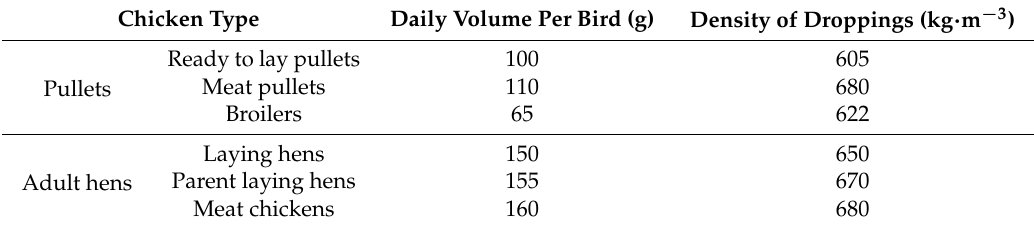
Table 2. Daily production of droppings of various types of chickens and its density